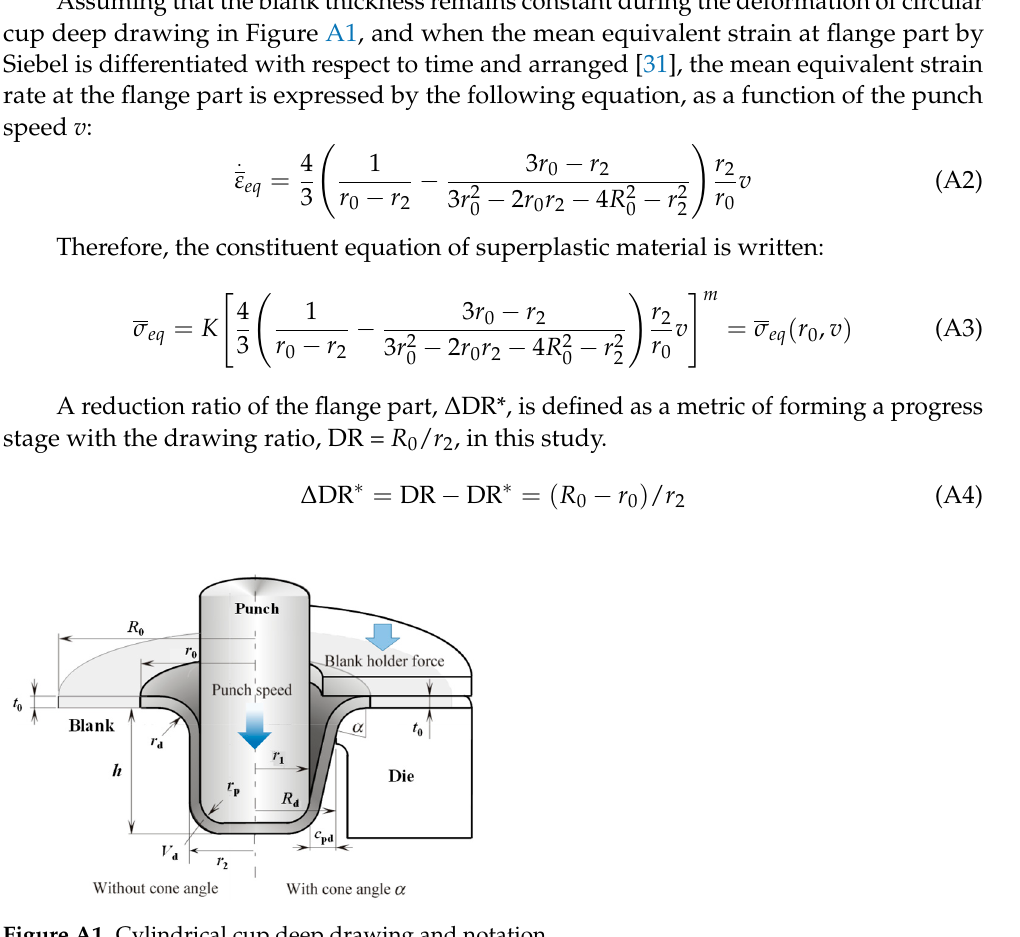
Figure A1. Cylindrical cup deep drawing and notation.